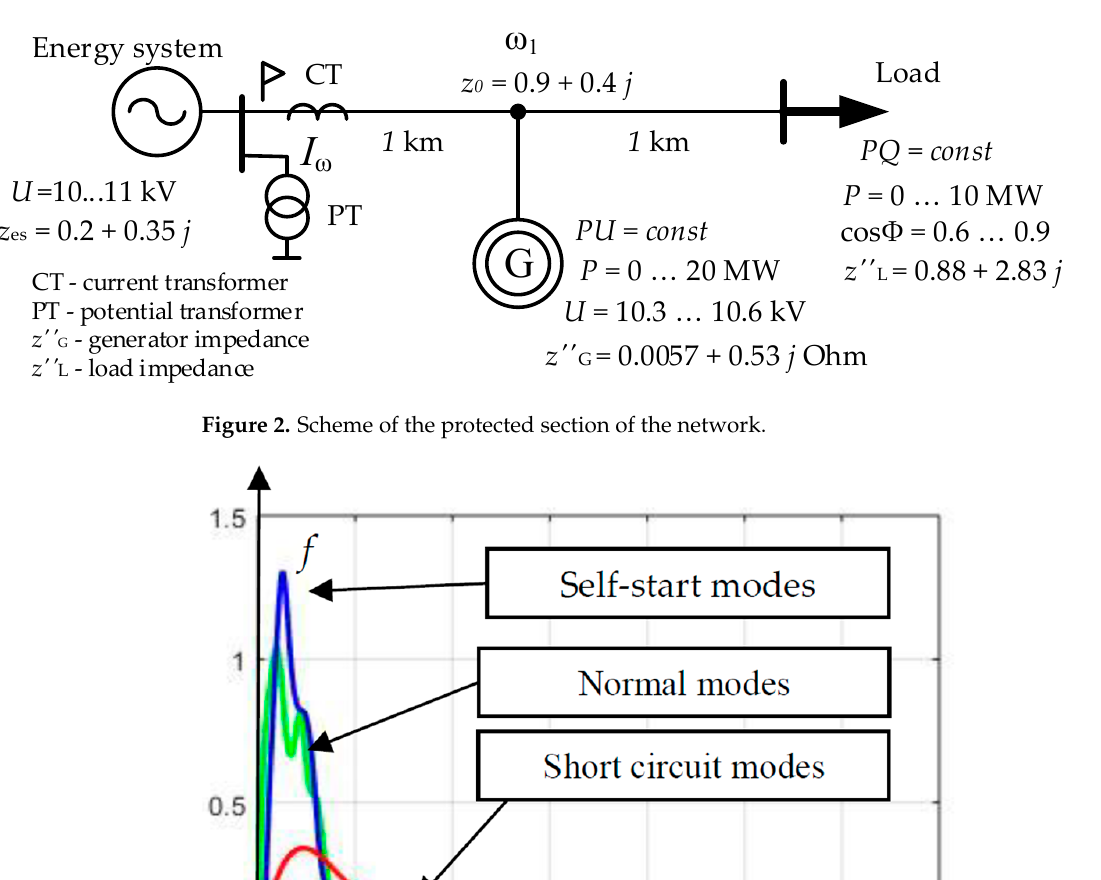
Figure 2. Scheme of the protected section of the network.